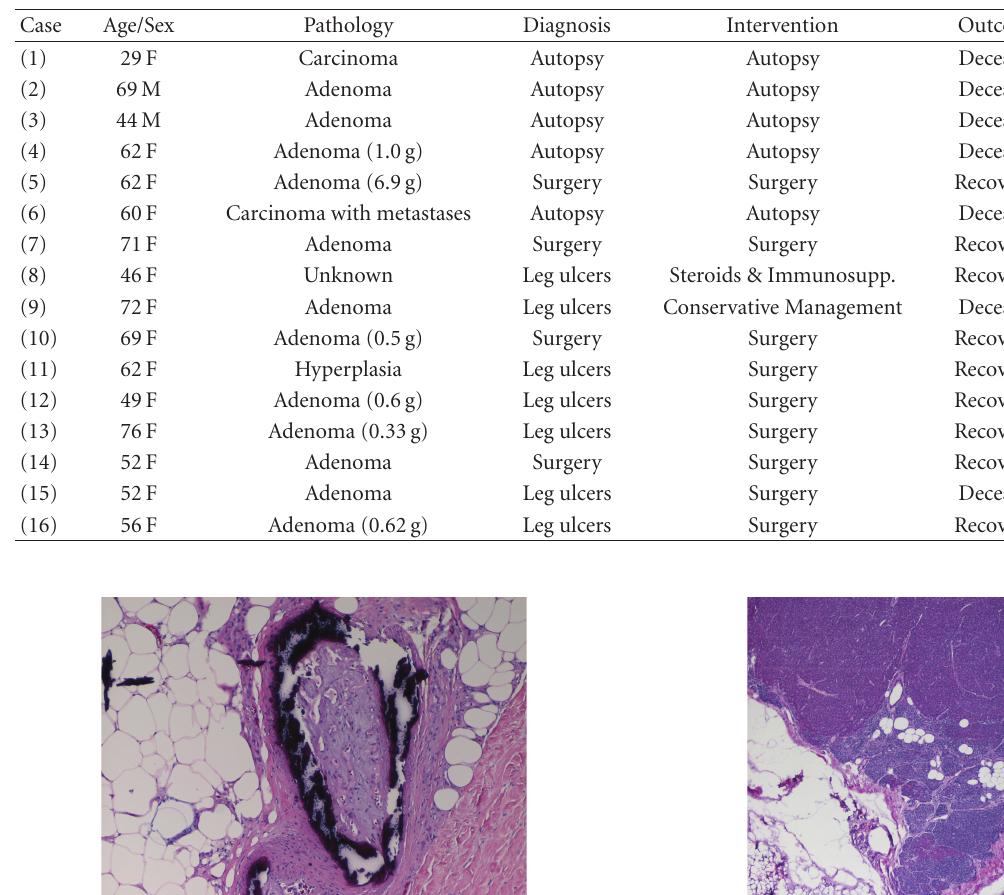
Table 1: A list of documented calciphylaxis secondary to primary hyperparathyroidism in the world literature.